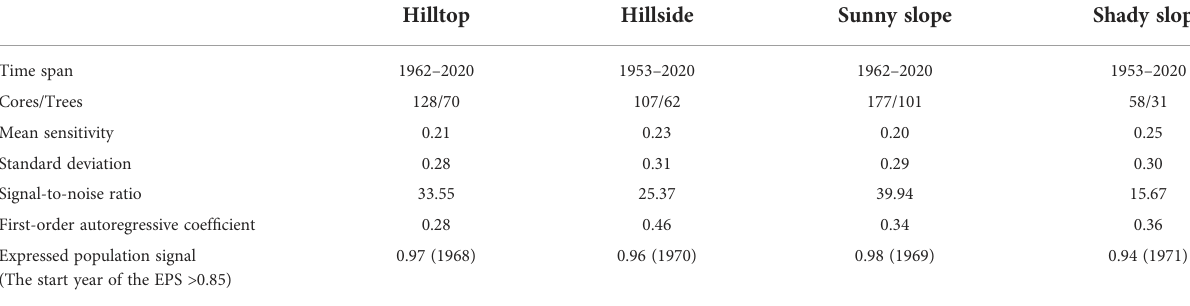
TABLE 2 Standard chronology (STD) statistics for all